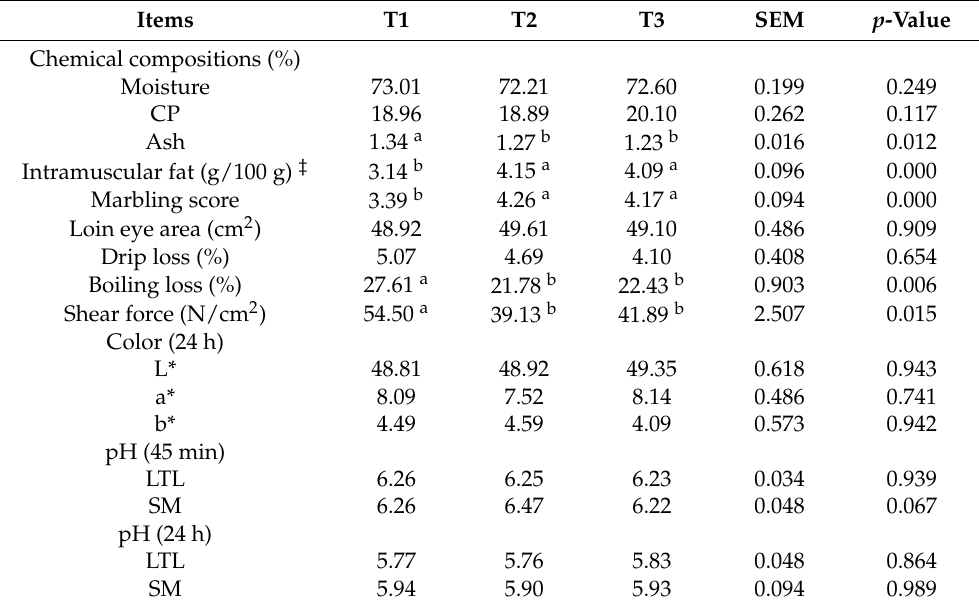
Table 5. Meat quality of a finishing crossbred pigs fed a low-lysine diet supplemented with perilla cake.